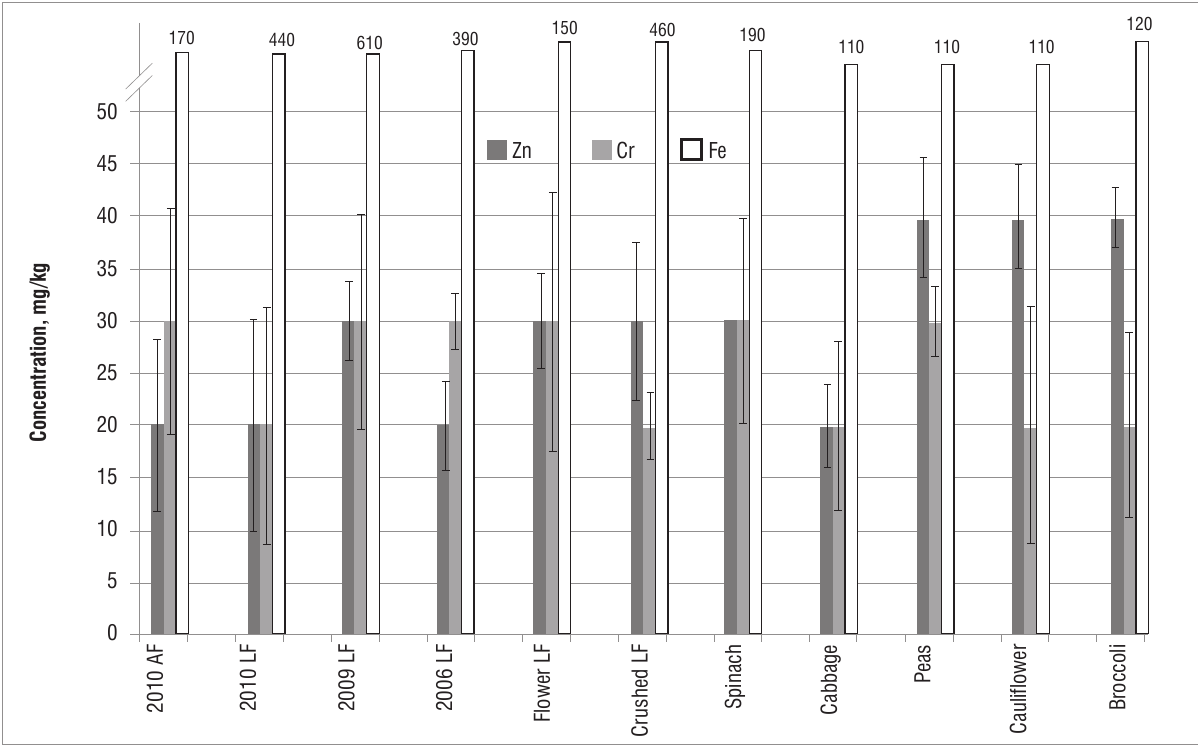
Figure 5: Concentration of major nutrient elements in moringa and selected vegetables.